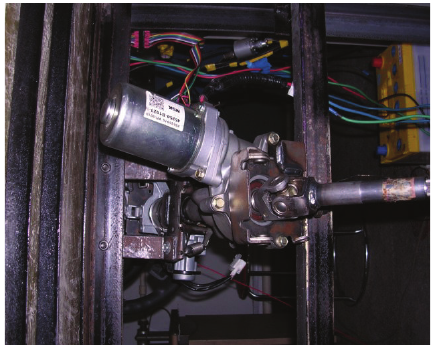
Figure 5: Motor driver for the test.